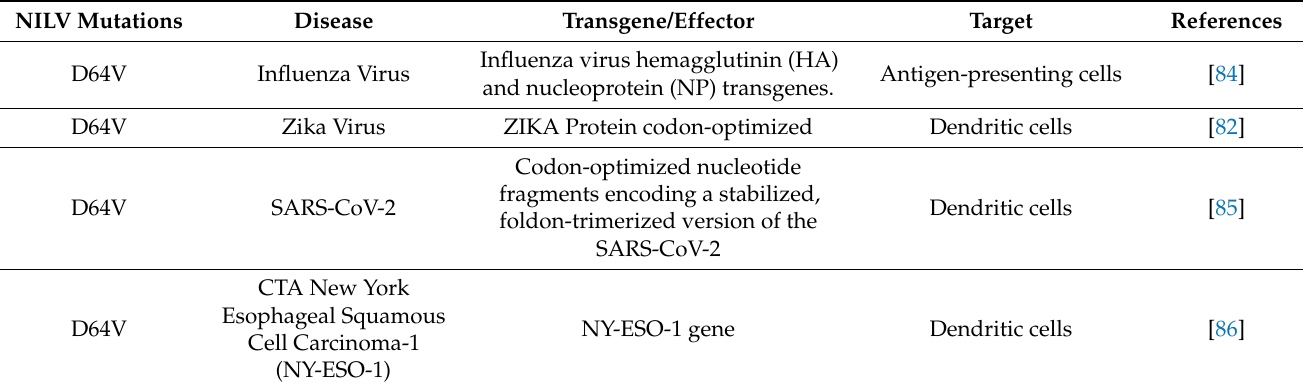
Table 5. Summary of elements used in developing non-integrating lentiviral vectors (NILVs) for vaccinations in pre-clinical studies conducted by the cited research teams. The first column lists the integrase mutations with subsequent columns categorizing the related diseases, target cells, and transgenes chosen for the mutations to be